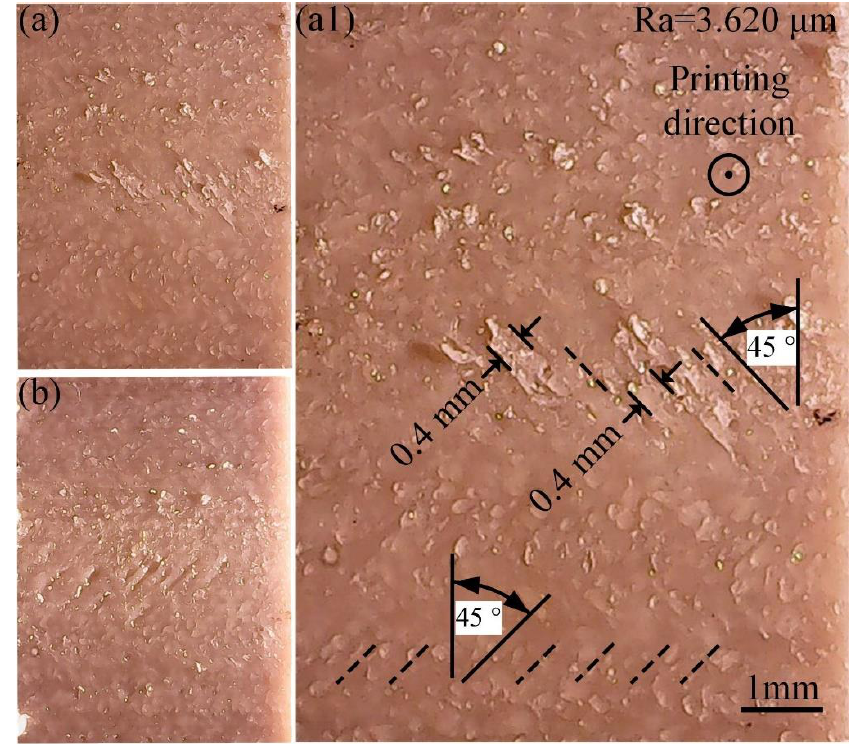
Figure 4. Surface morphology of milled specimens: ( a ) 0° printing, milling at the X direction; ( b ) 0° printing, milling at the Y direction; ( a1 ) enlarged image of subfigure ( a ).